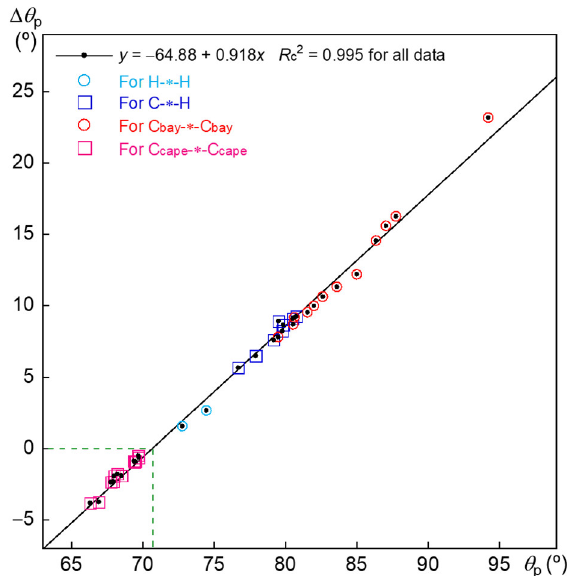
Figure 4. Plot of Δ θ p versus θ p for H-  -H, C-  -H, and C-  -C in 3 – 12 , evaluated with M06-2X/6- Figure 4. Plot of ∆ θ p versus θ p for H- ∗ -H, C- ∗ -H, and C- ∗ -C in 3 – 12 , evaluated with M06-2X/6- 311+G(3d,p), where Δ θ p = ( θ p – θ ). 311+G(3d,p), where ∆ θ p = ( θ p – θ